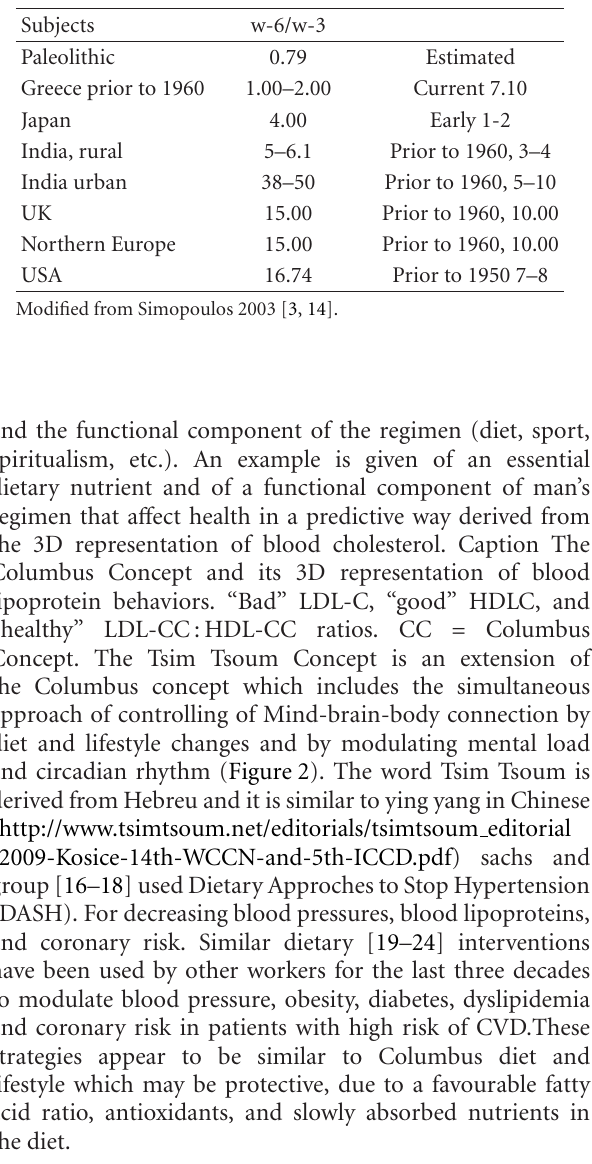
Table 5: Fatty acid ratio in the